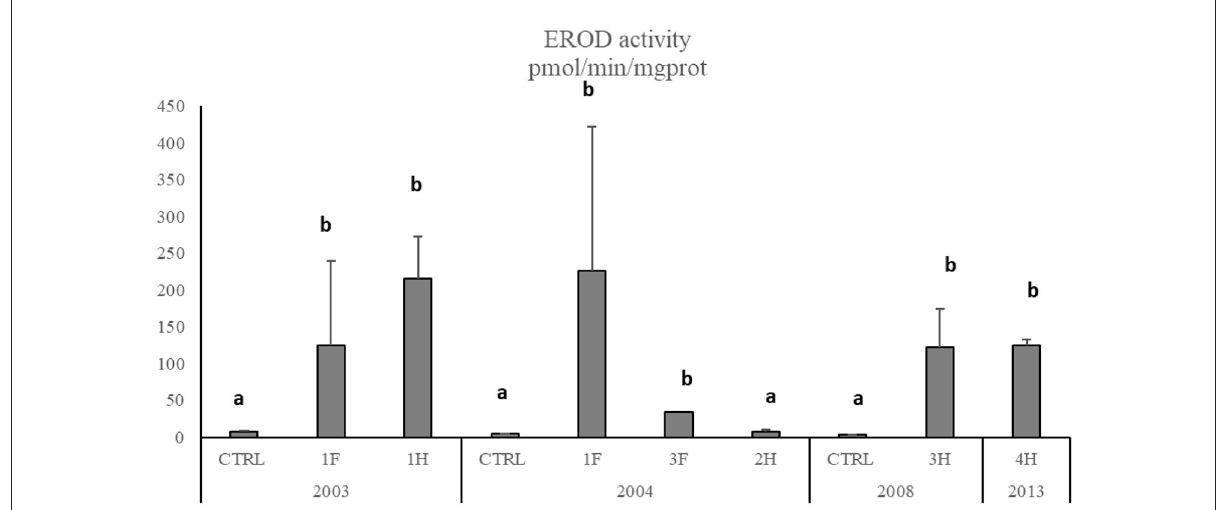
FIGURE5 EROD activity in M. barbatus . Data are expressed as mean ± standard deviation. Letters indicate differences among all the sampling sites, p <